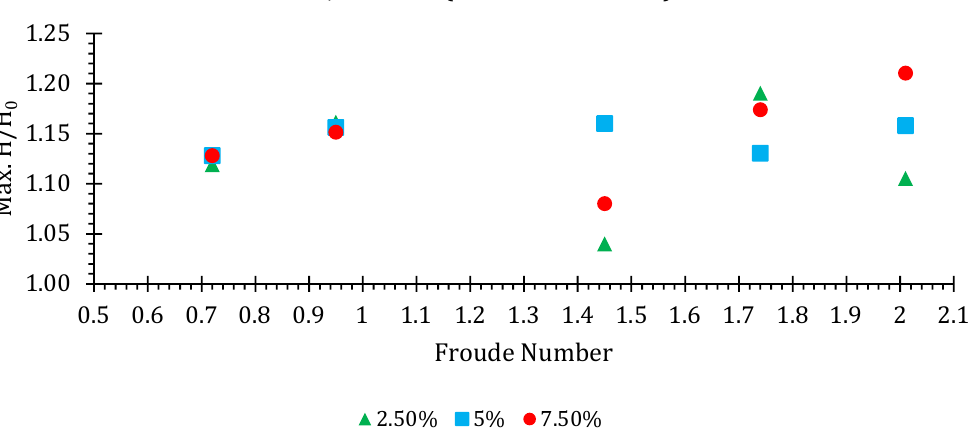
Figure 13. Maximum water height ratios in a 45 ◦ junction (narrow channel).